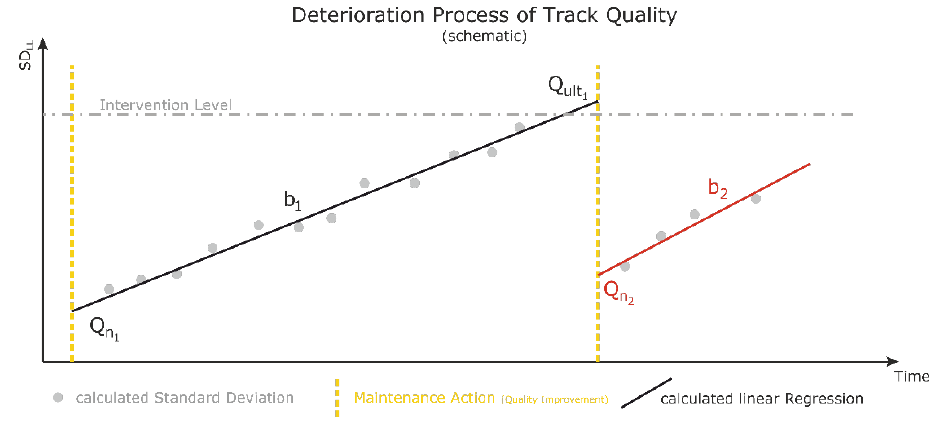
Figure 2. Showing the Deterioration Process of Track Quality and Quality Improvement due to Tamping.